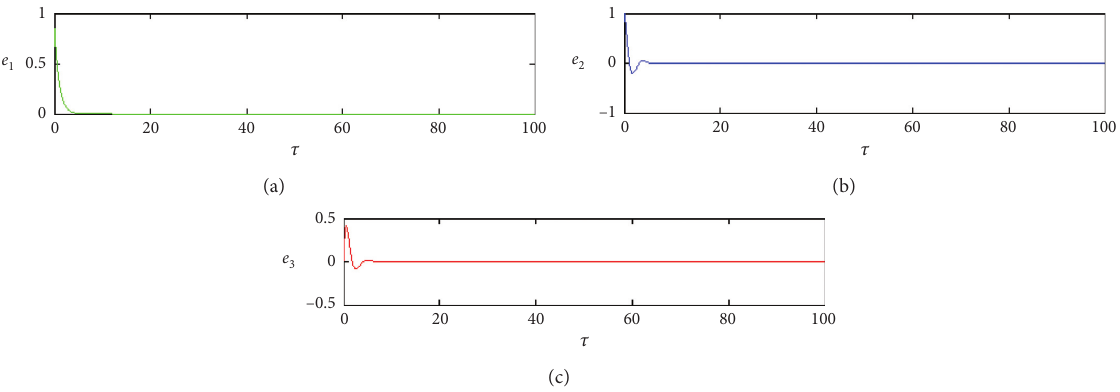
Figure 21: Temporal evolutions of the estimated gains of b, w (c) 1.6 (in red), respectively.